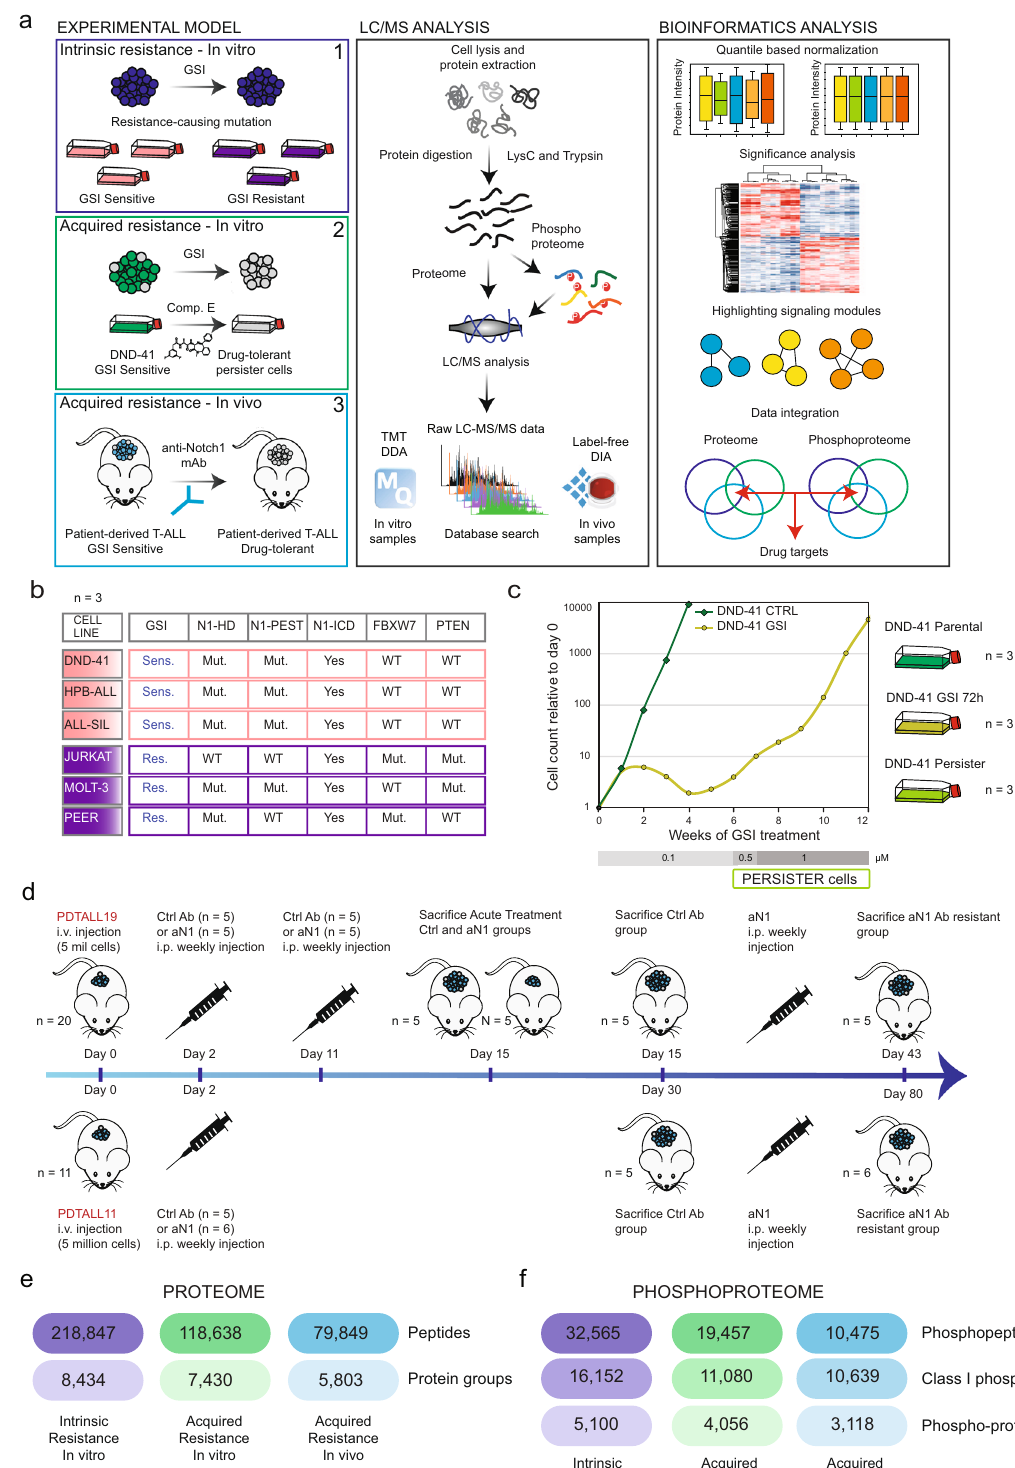
Sacrifice Ctrl Ab group